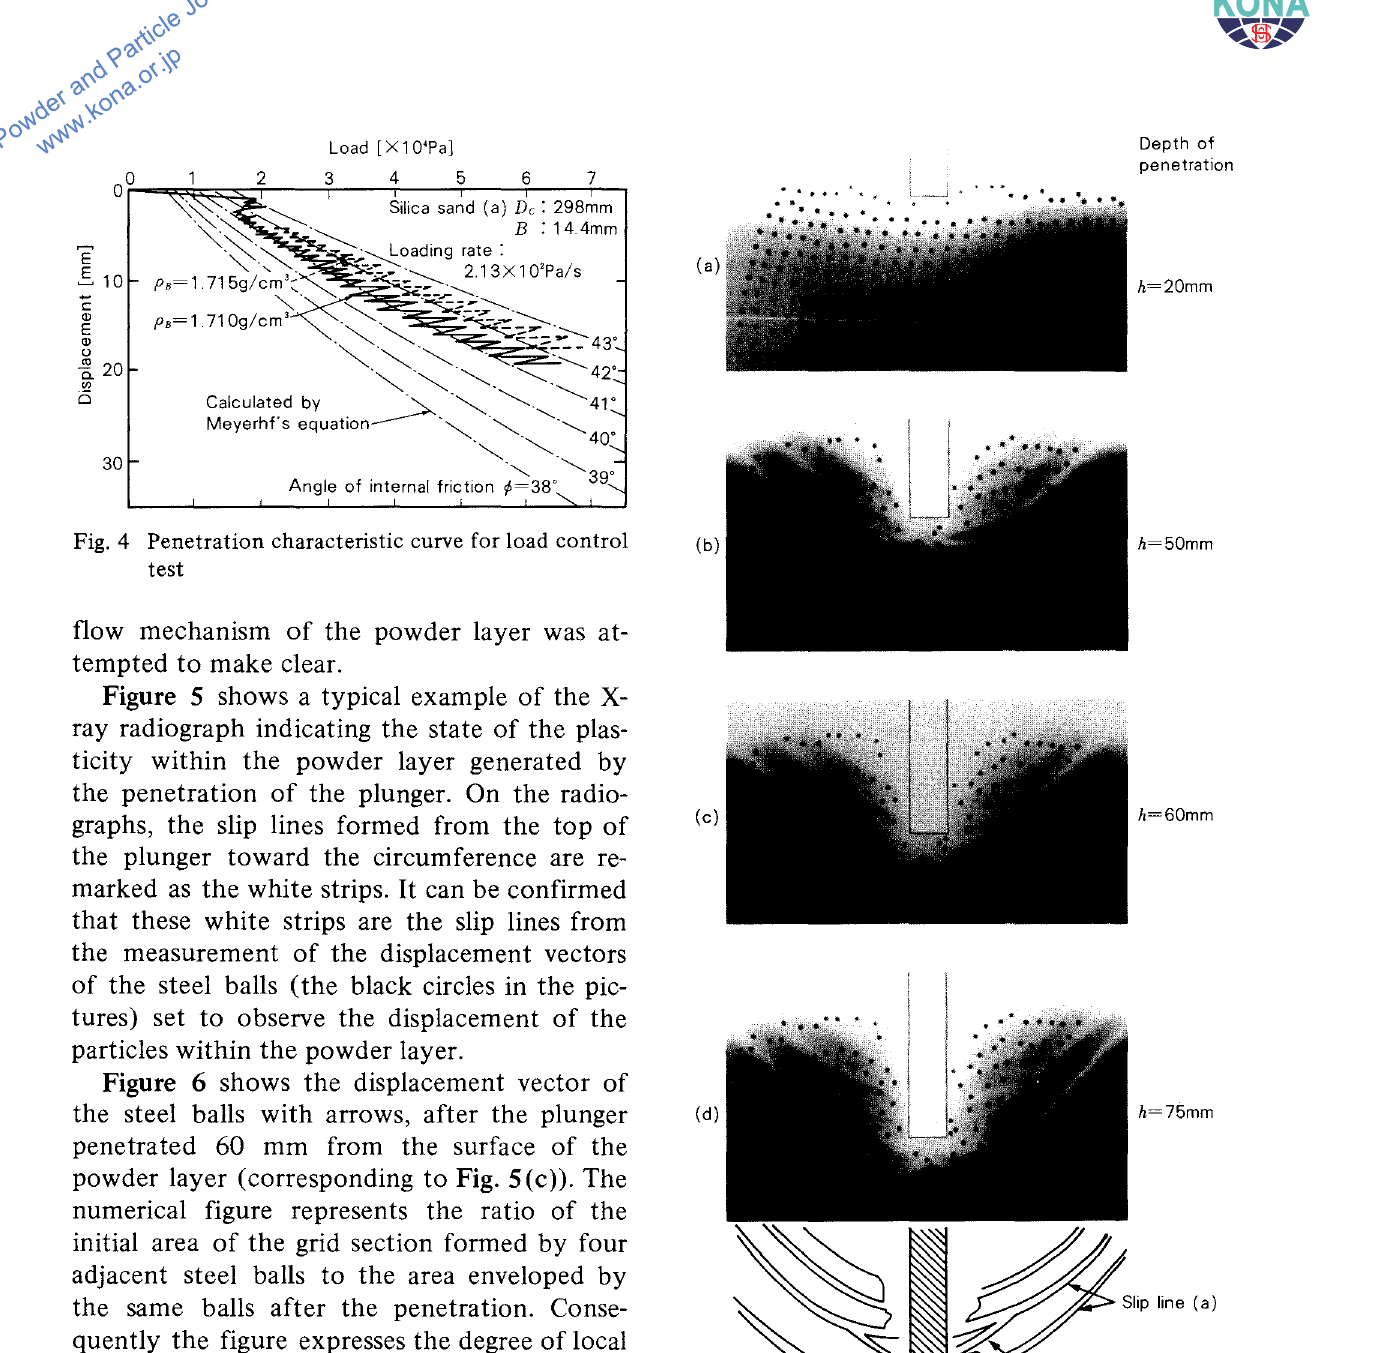
Fig. 5 X-ray radiographs of the plasticity pattern generated by the penetration of a plunger into powder bed